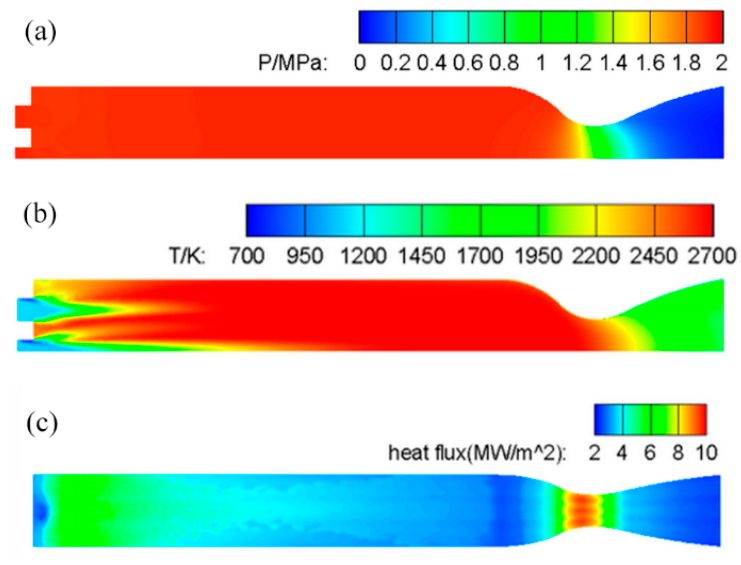
Figure 10. Contours of pressure, temperature, and heat flux. ( a ) Contour of pressure distribution inside the thrust chamber; ( b ) contour of temperature distribution inside the thrust chamber; ( c ) contour of heat flux distribution near the wall surface.